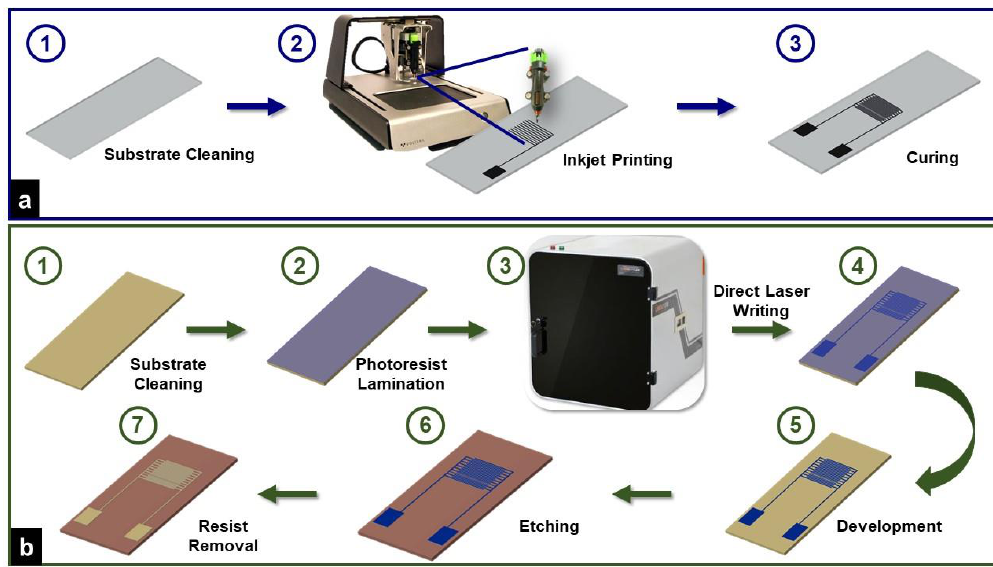
Figure 2. Overall step-by step fabrication scheme for ( a ) Carbon ink-based IDE printed on glass slide ( b ) Photolithography- based DLW IDE on a copper-cladded FR4 PCB board.